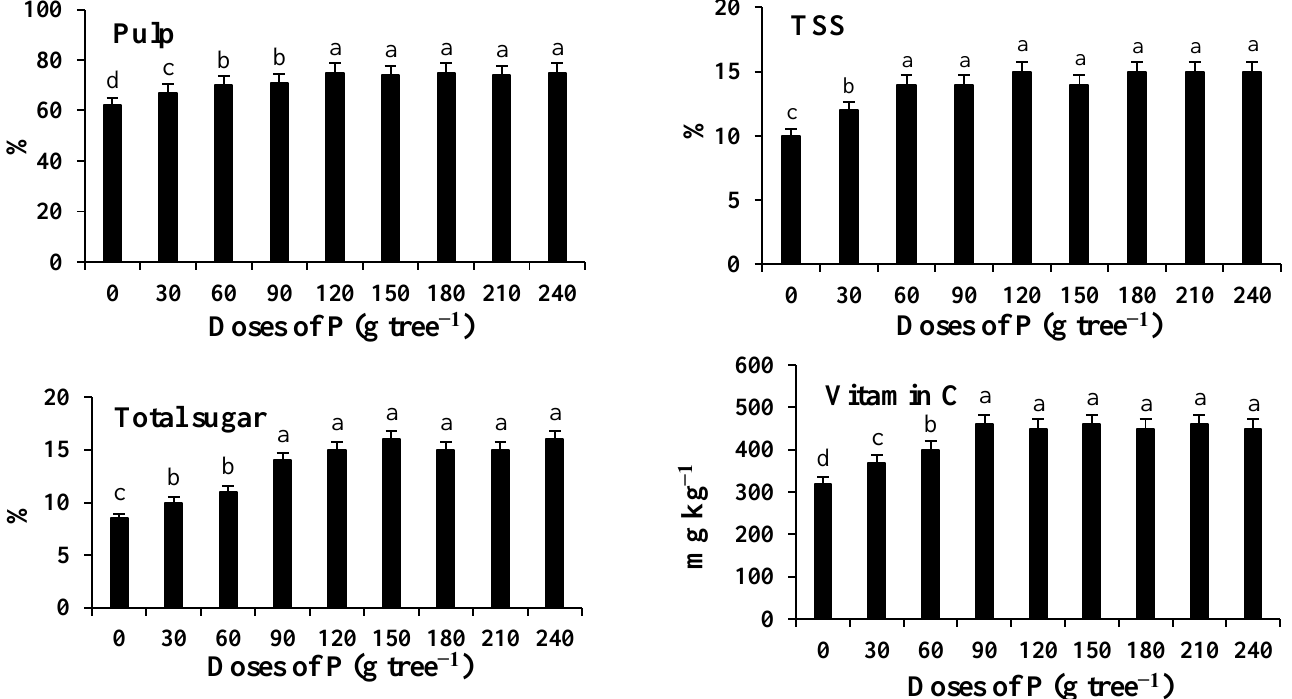
Figure 4. The effect of P doses on mango fruit quality. Means ( ± SE, n = 16) denoted by different letters indicate significant difference according to Duncan’s test at p < 0.05.